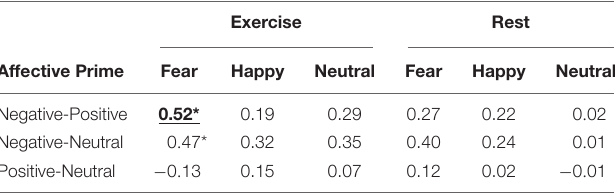
TABLE 1 | Estimation statistics on Response times for for Condition, Facial Expression and Affective Prime. Exercise Rest Affective